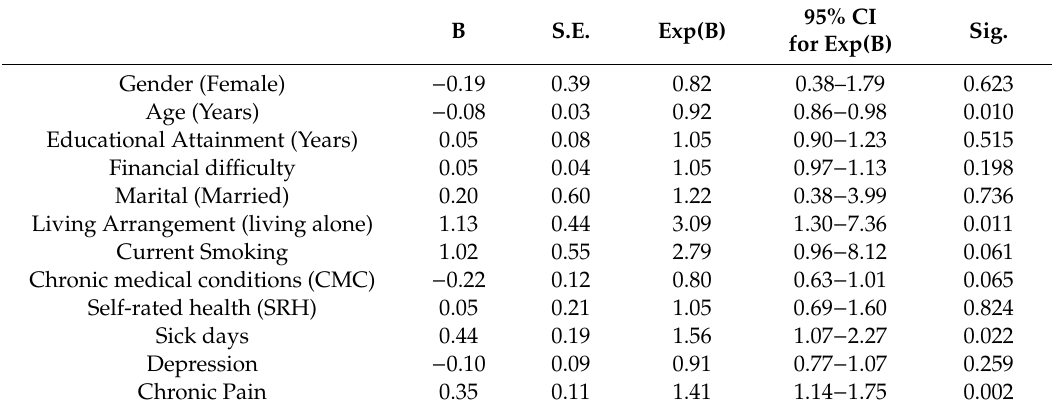
Table 3. Multivariable logistic regression model with drinking as the outcome.